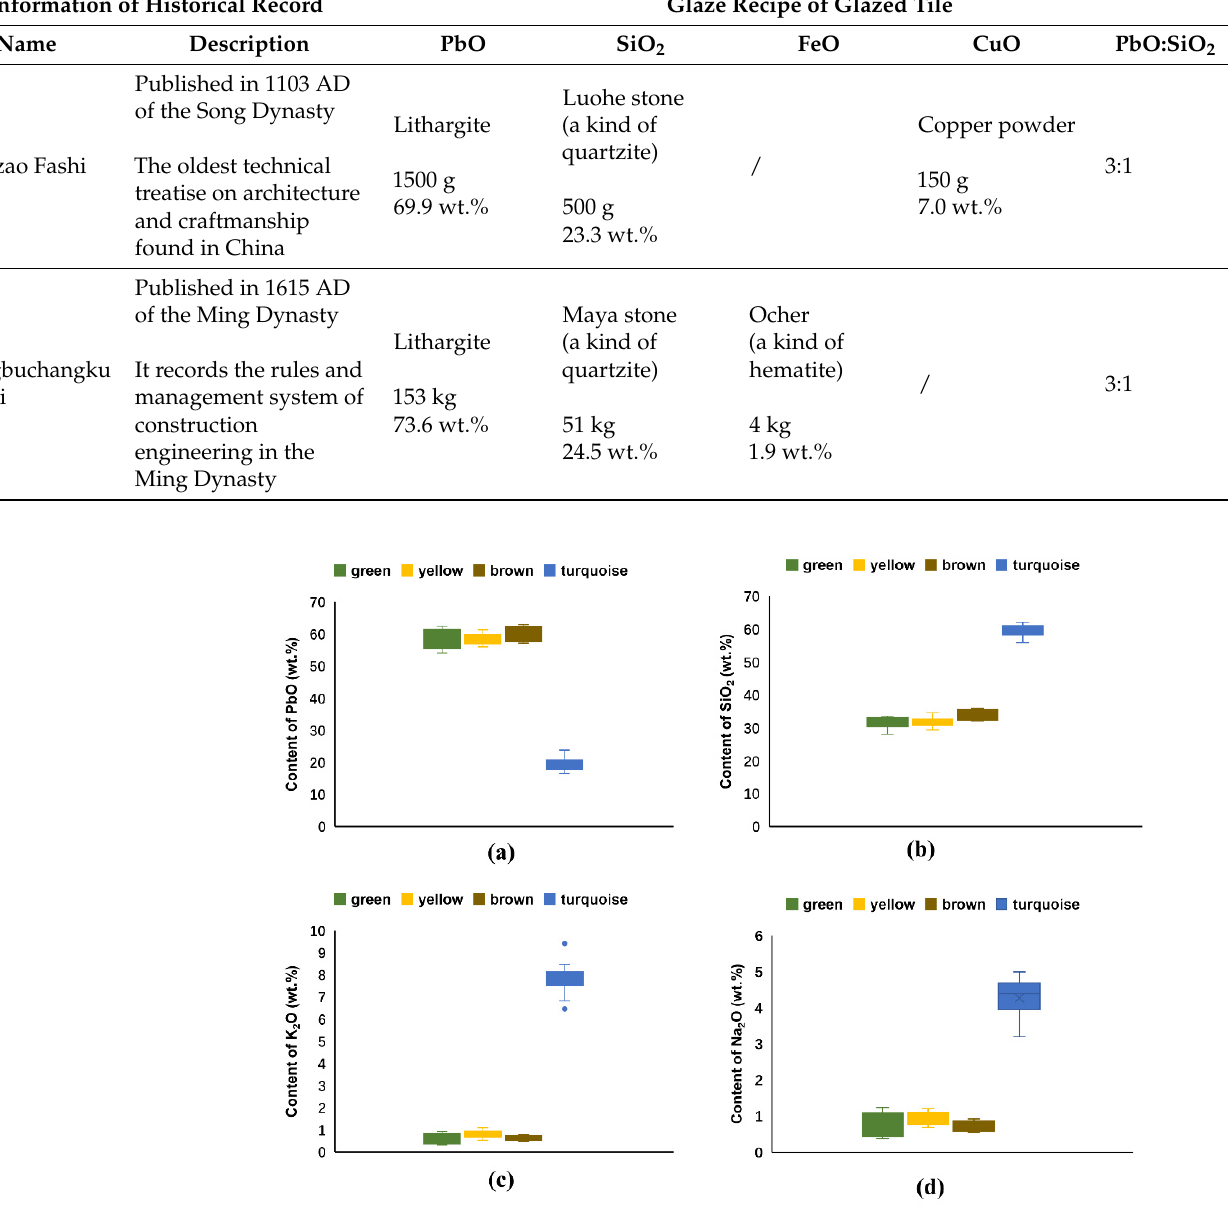
Figure 8. Plots of chemical compositions in glaze samples with different colors. ( a ) Content of